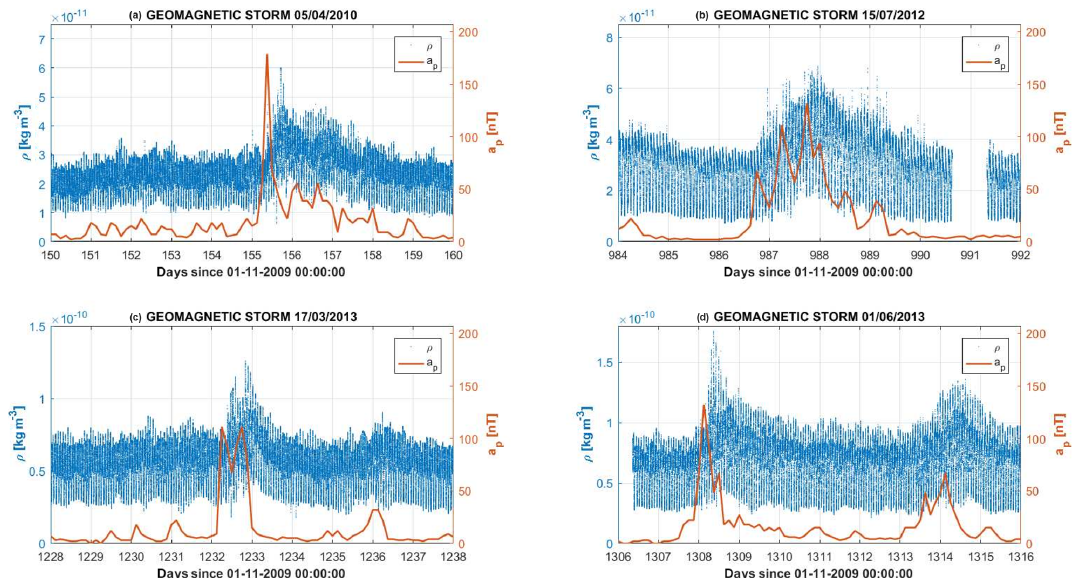
Figure 4. Thermospheric-density ρ (blue line) and Ap index (red line) during four geomagnetic storms occurred over the course of the GOCE mission: (a) 5 April 2010 (day 155), (b) 14 July 2012 (day 986), (c) 13 March 2013 (day 1232), and (d) 1 and 7 June 2013 (days 1308 and